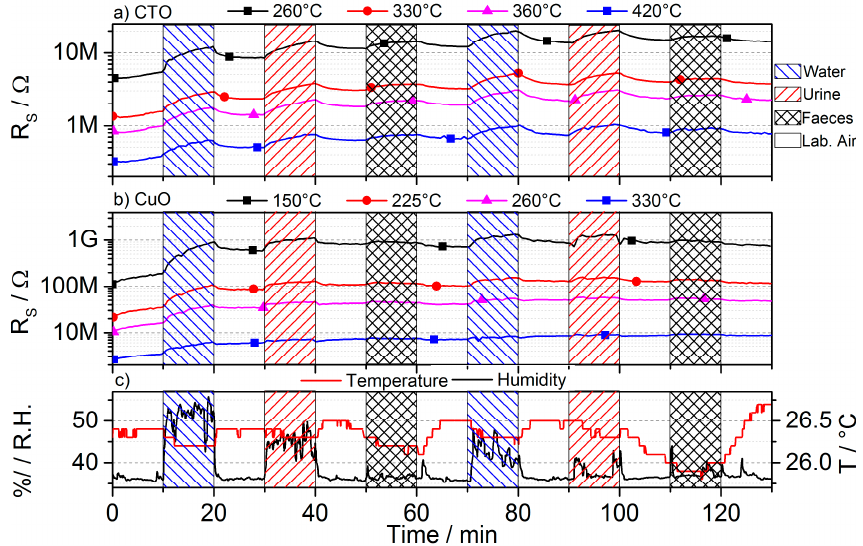
Figure 10. Sample sensor module raw data obtained after the exposure towards 10 min of humid laboratory air, above a urine reservoir, above a feces reservoir, and in laboratory air. ( a ) CTO and ( b ) CuO resistivity response ( c ) temperature and humidity.